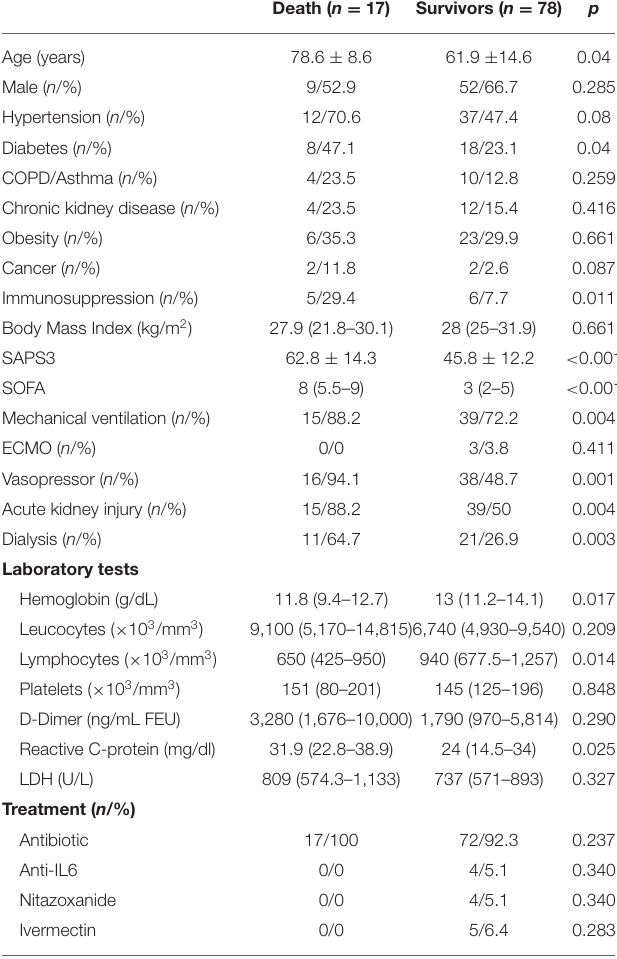
vs. 9.8%; p = 0.001) and received mechanical ventilation TABLE 2 | Comparative clinical data, laboratory tests, and treatment in patients who had undergone death and survivors. Death ( n = 17) Survivors ( n = 78)